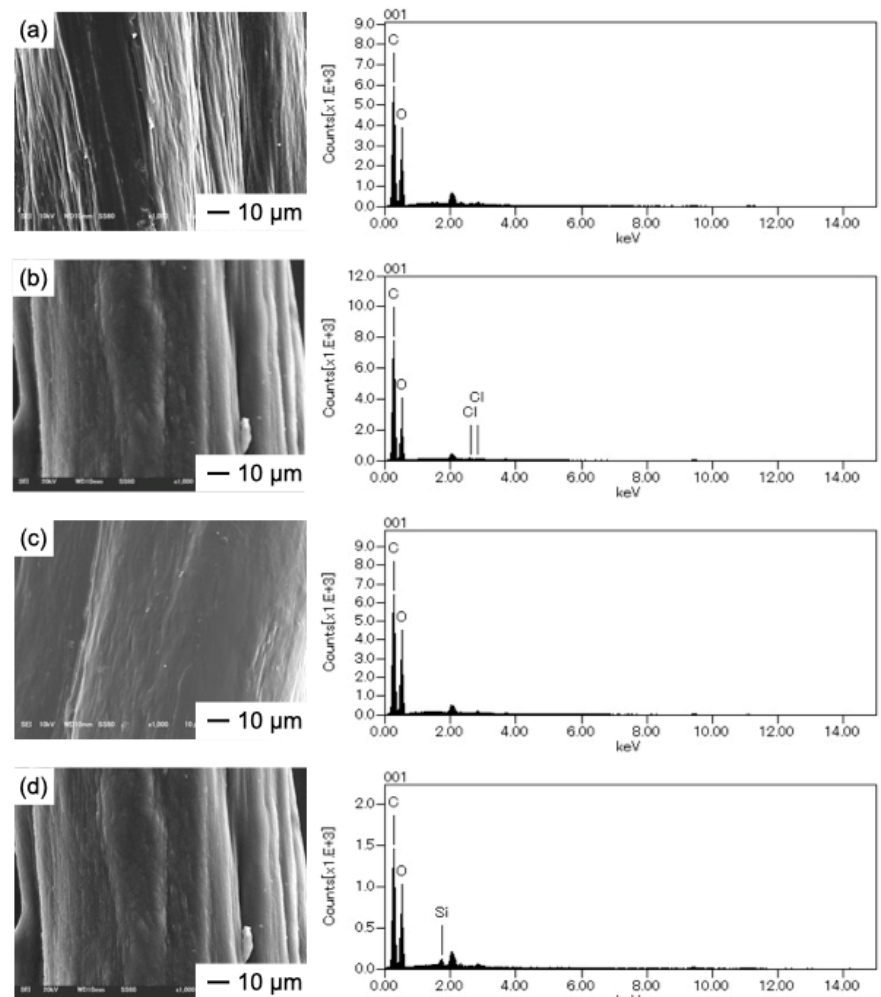
Molecules 2020 , 25 , x FOR PEER REVIEW Figure 6. SEM images and EDS spectra of the chitosan − TMSA microfibers. ( a ) Ch; ( b ) ChTMSA0001; ( c ) ChTMSA0005; and ( d ) ChTMSA001. Table 2. Ninhydrin test results indicating the number of amino groups remaining in the chitosan − TMSA microfibers.